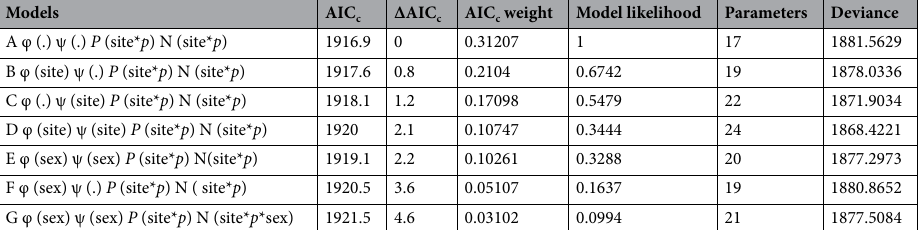
Table 3. Comparison of seven competing models built on apparent survival (φ), transition rate ψ, probability of capture ( P ) and abundance (N) ranked from the best candidate model (lowest AICc value). Parameters were constant (.) or varied by site, sex or season—primary period ( p ). Probability of capture was equal to recapture ( P =